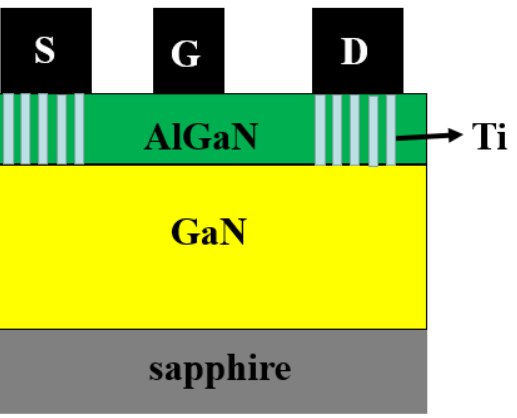
Figure 6. Schematic structure of AlGaN/GaN HEMT with holes etching in the ohmic region. Universities and industries have conducted studies on the ohmic contact formation mechanism. Two methods are regarded as the mechanism to form ohmic contact to Al- GaN/GaN HEMT: (1) a field emission (FE) tunneling mechanism [64–66] via the formation of a thinner high doping or a lower barrier; and (2) a spike mechanism [67,68] by TiN direct electron path formation along the dislocation. In the FE tunneling mechanism, Ti reacts with the GaN or AlGaN layer to form TiN. N should be extracted from GaN or AlGaN, generating a highly n-doped interface region, which is responsible for the occurrence of FE tunneling. The work function of TiN (3.74 eV) is lower than Ti (4.33 eV), which is believed to lower the Schottky barrier for low-resistance ohmic contact formation. In the spike mechanism, the TiN projections forming along the dislocation places penetrate through the AlGaN layer under a high temperature, which sets up a direct electron path connecting the 2DEG and the ohmic metal. This method is believed to be more efficient in electron transferring than the FE tunneling mode. With the improvement of AlGaN/GaN material growth, the spike phenomenon, which penetrates through the whole AlGaN layer, becomes less likely to happen. The cross-sectional diagrams of both physical models are shown in Figure 7, which reveals the ohmic contact formation mechanism.